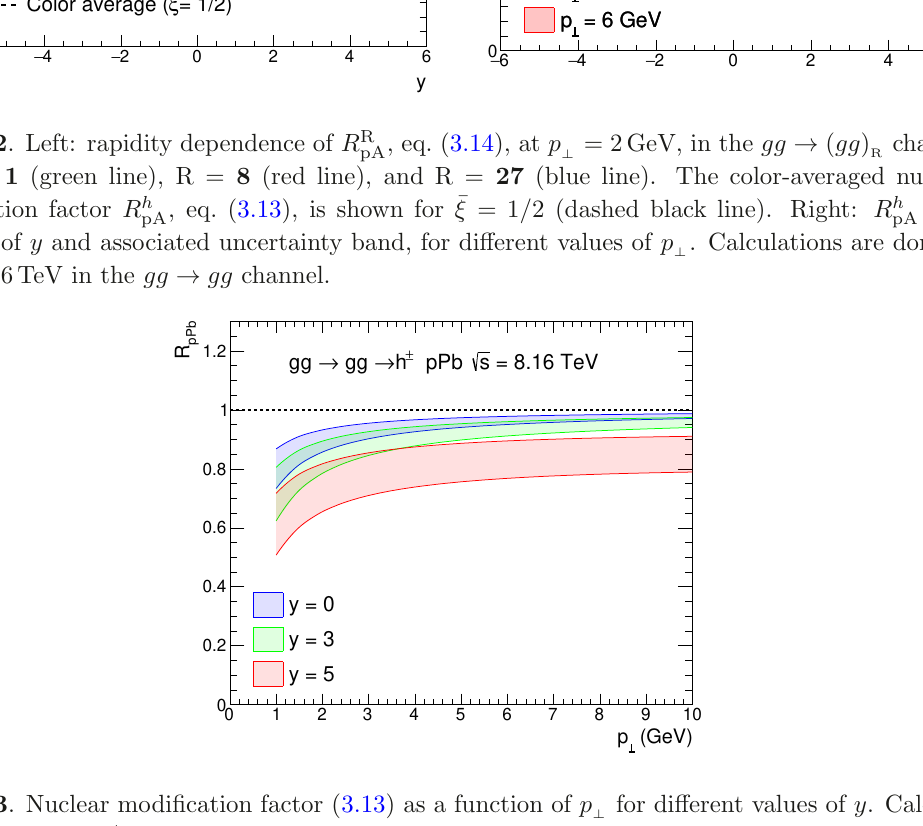
for di(cid:11)erent values of y . Calcula- ? gg !